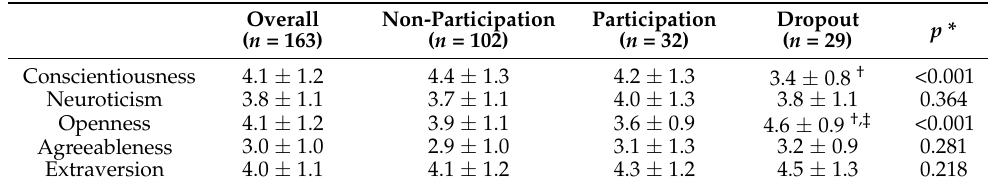
Table 2. Comparisons of personality traits at discharge among groups based on the participation in outpatient CR for three months.